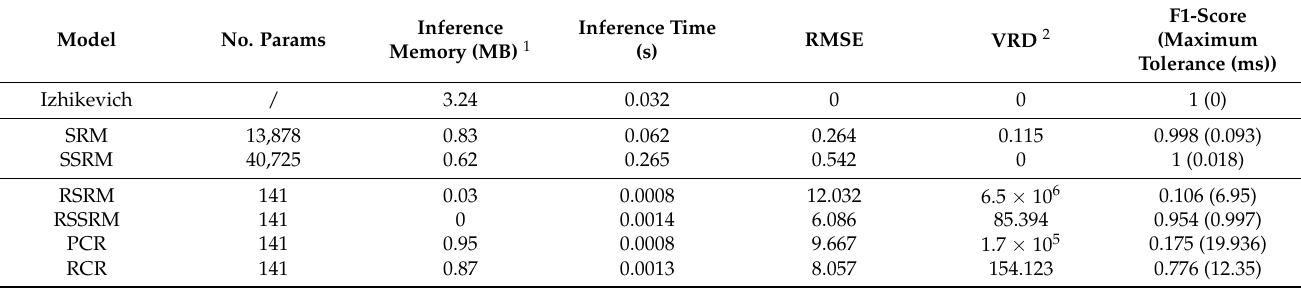
Table 5. Average performance on multiple-spike firing